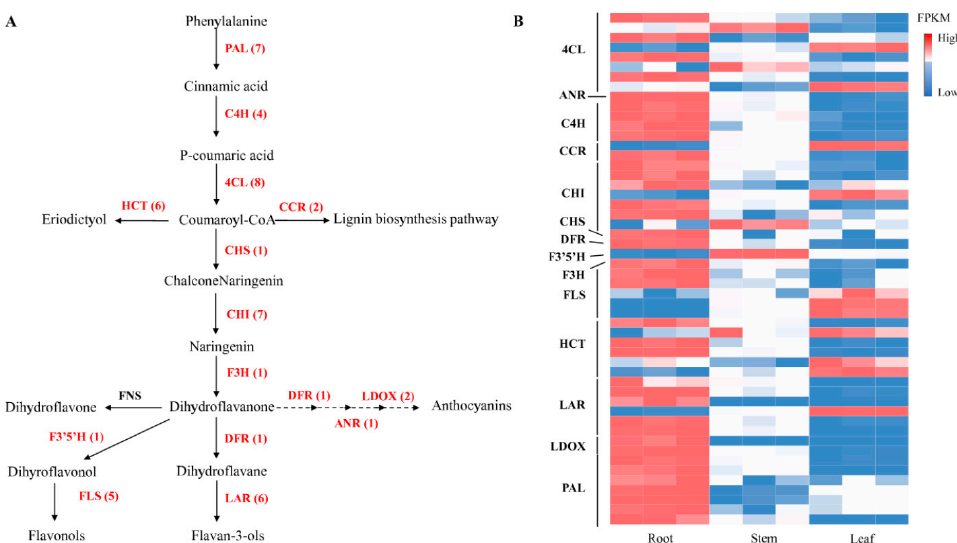
Figure 4. A schematic representation of phenylpropanoid and flavonoids biosynthesis in C. rotundifo- lia. ( A ) Proposed biosynthetic pathway modified from literature and the KEGG pathway database.